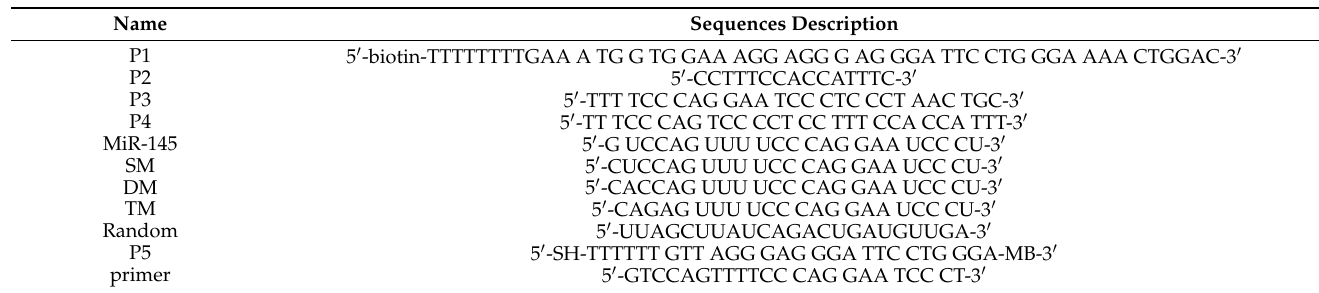
Table 2. Sequences of the nucleic acid used in the